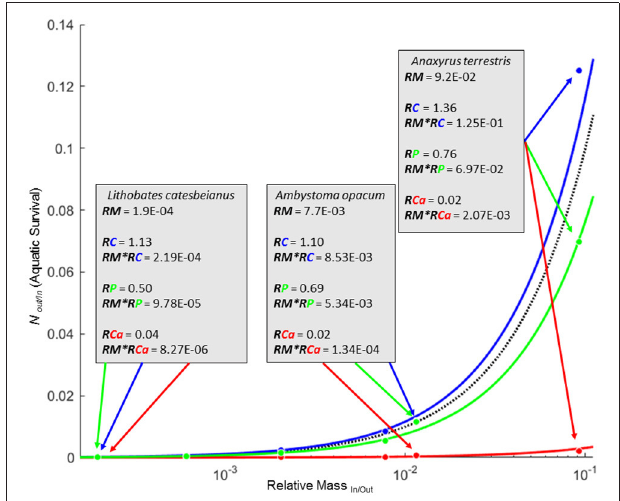
FIGURE 2 | Zero net transfer isoclines (ZNTI) for biomass (black), C (solid blue), P (solid green), and Ca (solid red) for 6 amphibian species where P corresponds to balanced flux between terrestrial and aquatic systems for biomass, C, or Ca. Isoclines for C and Ca depict the average RE for C and Ca for the six amphibians. Details for three species are shown in boxes with arrows pointing to their corresponding location on the isoclines. Regions between lines represent simultaneous import and export of two different materials. For example, the region between biomass and Ca isoclines represent values at which there would be an import of biomass and an export of